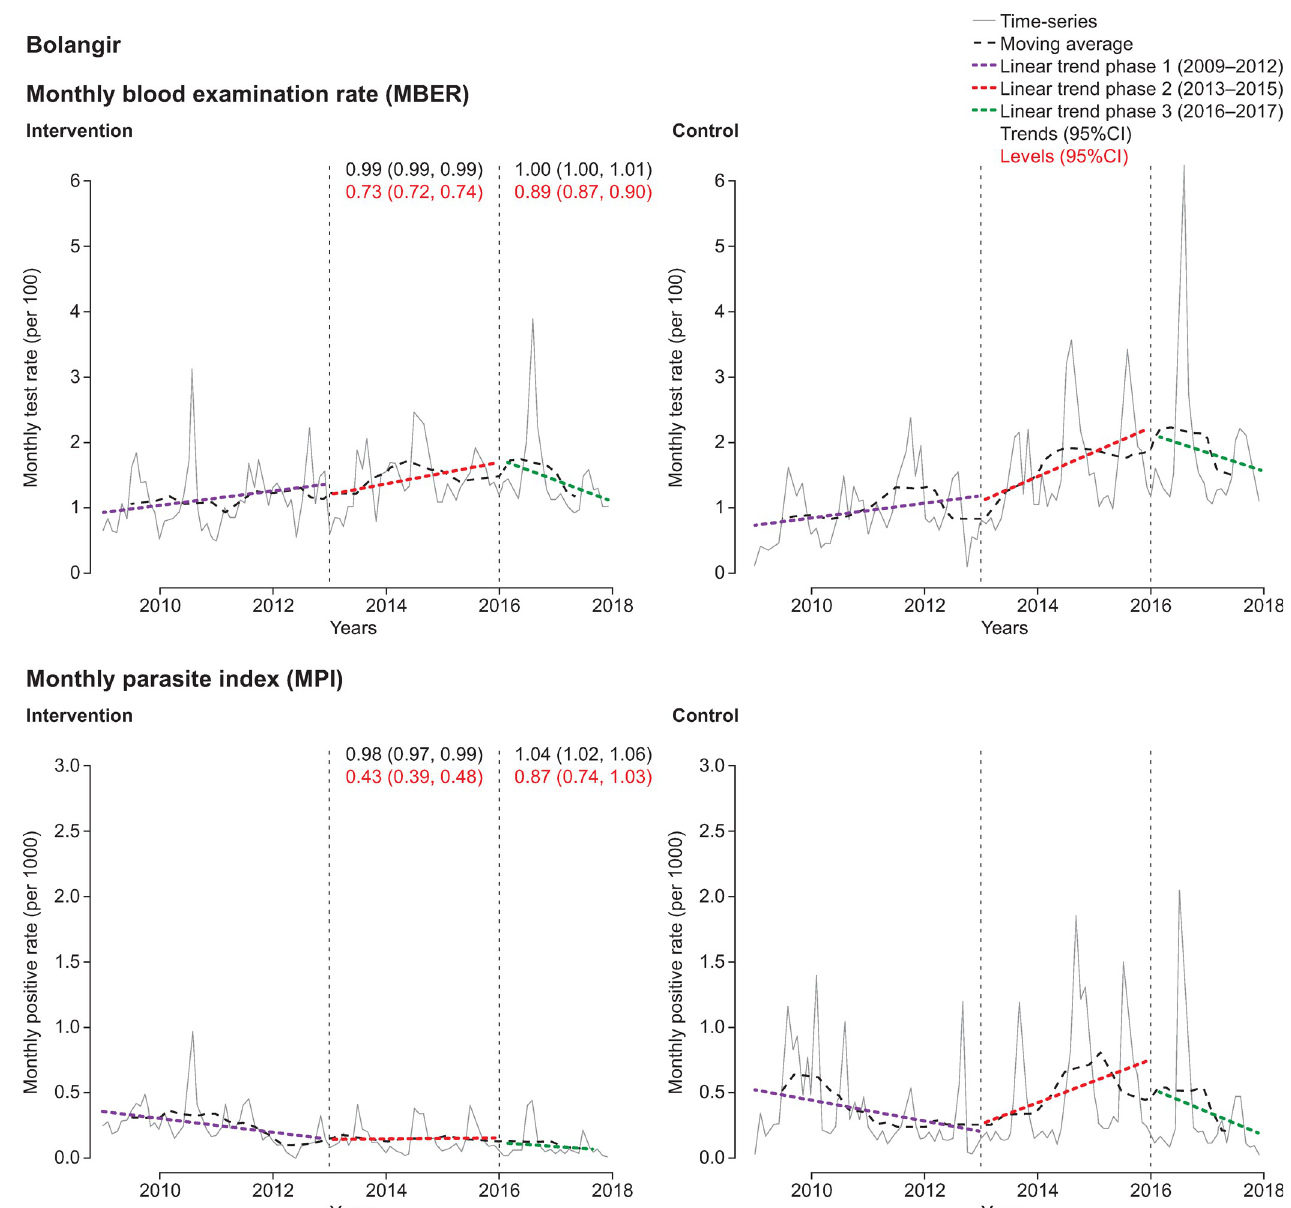
Fig 4. Interrupted time-series analysis of changes in malaria indices for Bolangir. MBER, monthly blood examination rate = total number of slides examined in a month x1000 / total population; MPI, monthly parasite index = total number of positive slides for parasite in a month x1000 / total population.